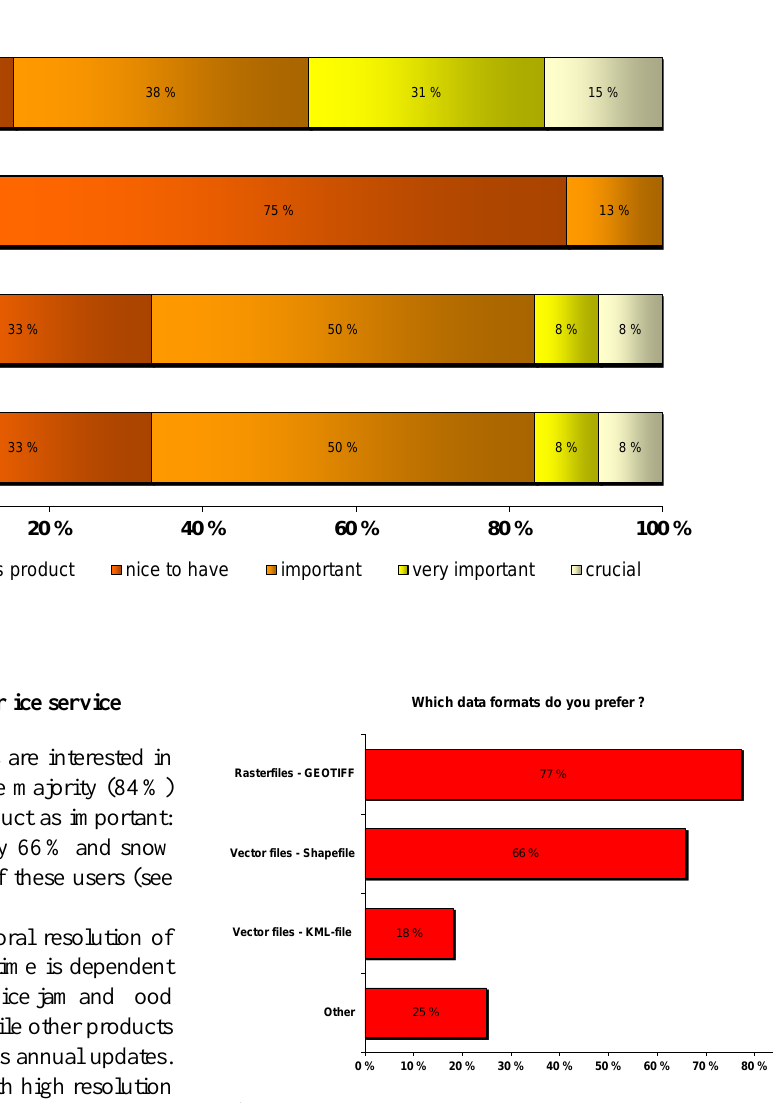
Figure 7. Preferred data